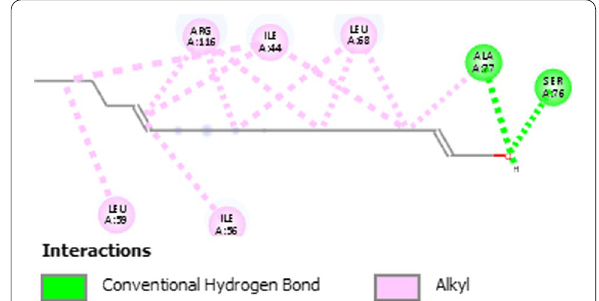
Fig. 14 2D interaction of compound 2 with crystal structure of P. aeruginosa (PDB: 2OZ6)